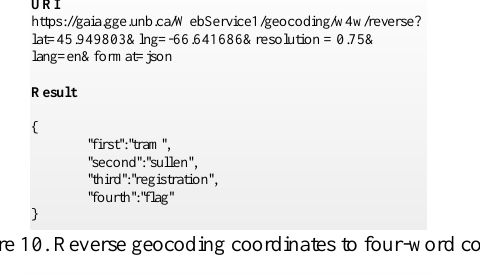
Figure 10. Reverse geocoding coordinates to four-word code